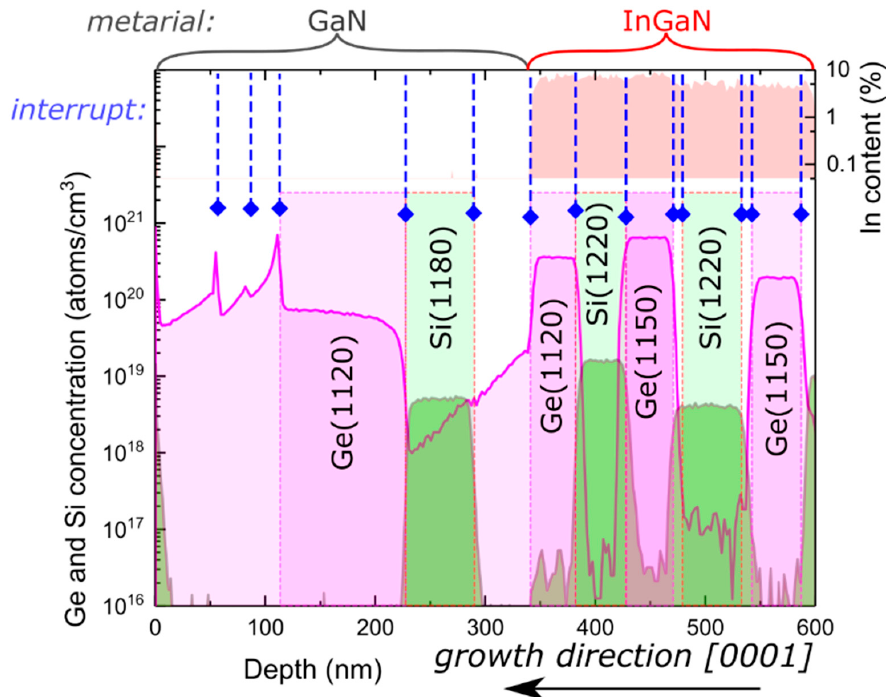
Figure 4. Germanium concentration measured by SIMS as a function of depth for a stack of InGaN:Ge and GaN:Ge layers separated by layers of the same composition that were intentionally undoped or doped with silicon. InGaN and GaN parts of the crystal are marked above the plot. Indium content as a function of depth is shown on the right-hand side axis. Places where germanium effusion cell was opened are marked by additional shading with germanium cell temperature in Celsius (which was kept constant in this experiment). Places where all atomic fluxes were closed to allow for excess gallium and indium desorption are marked with dashed blue lines and a diamond symbol.